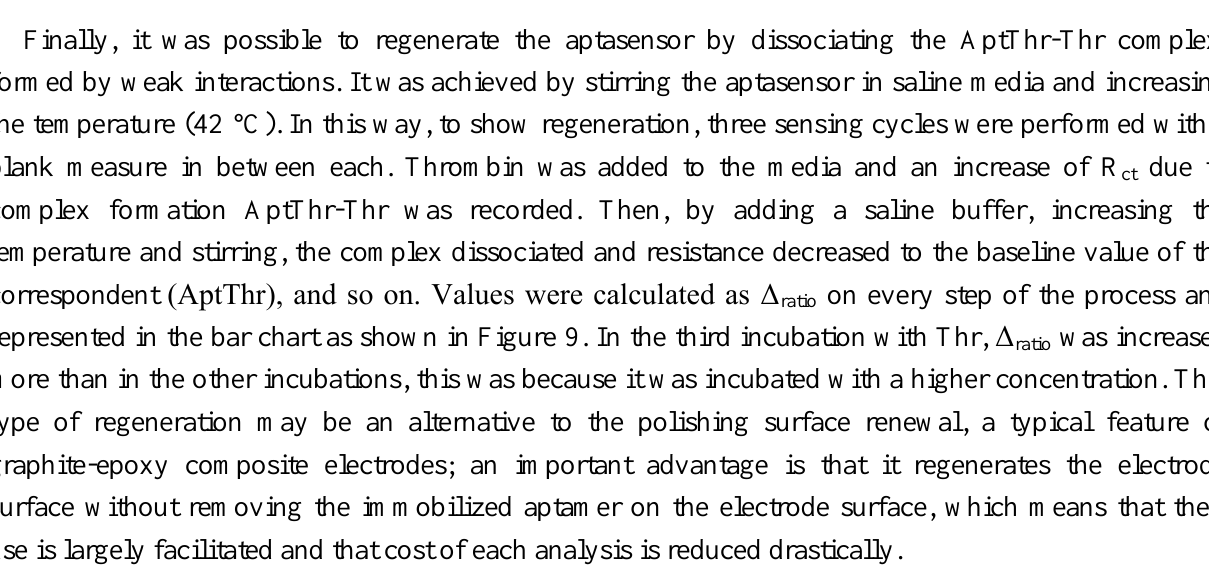
Figure 9. Signals obtained for three consecutive processes of regeneration. [Thr] used: 7.5 pM (1 and 2), and 75 pM (3). Uncertainty values corresponding to replicated experiments (n =